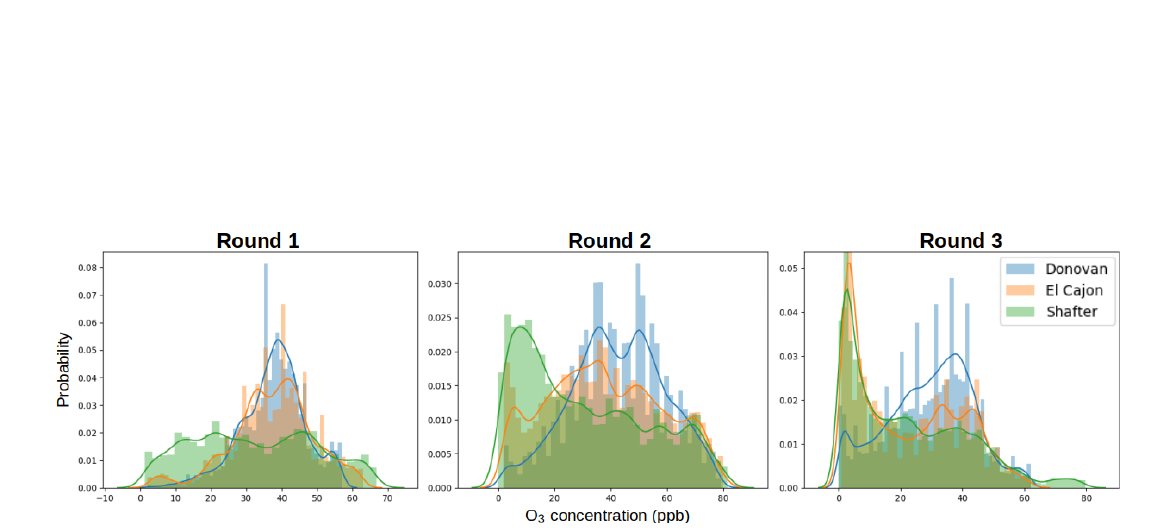
Figure A4. O 3 distributions for each location, by